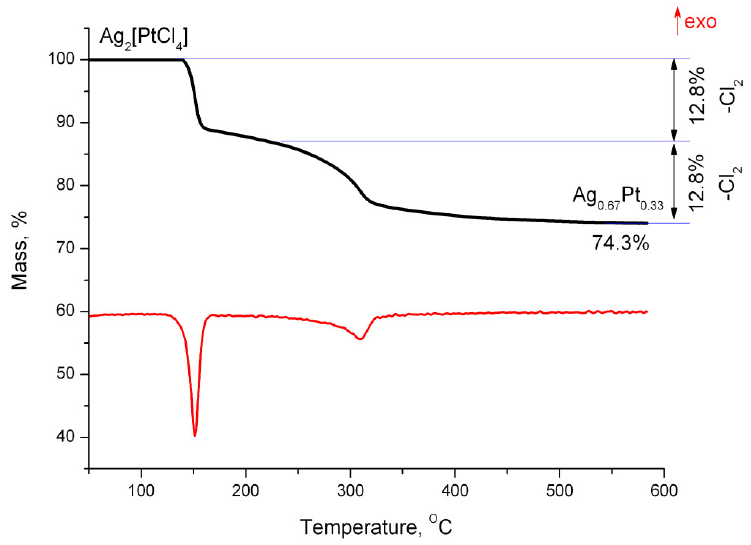
Figure 4. Mass loss curves and differential thermal analysis of Ag 2 [PtCl 4 ] in a hydrogen atmosphere.